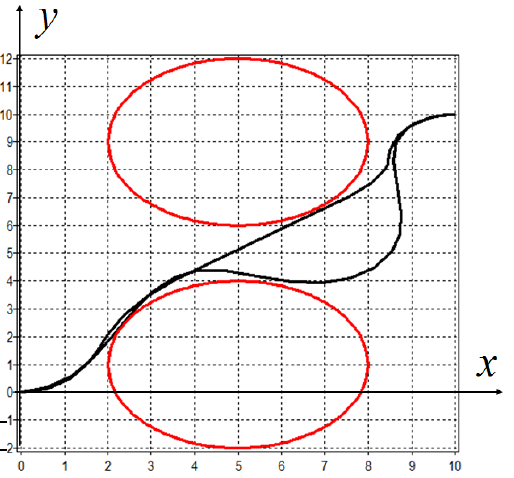
Figure 2. Optimal trajectories of robots on the plane { x , y } for direct